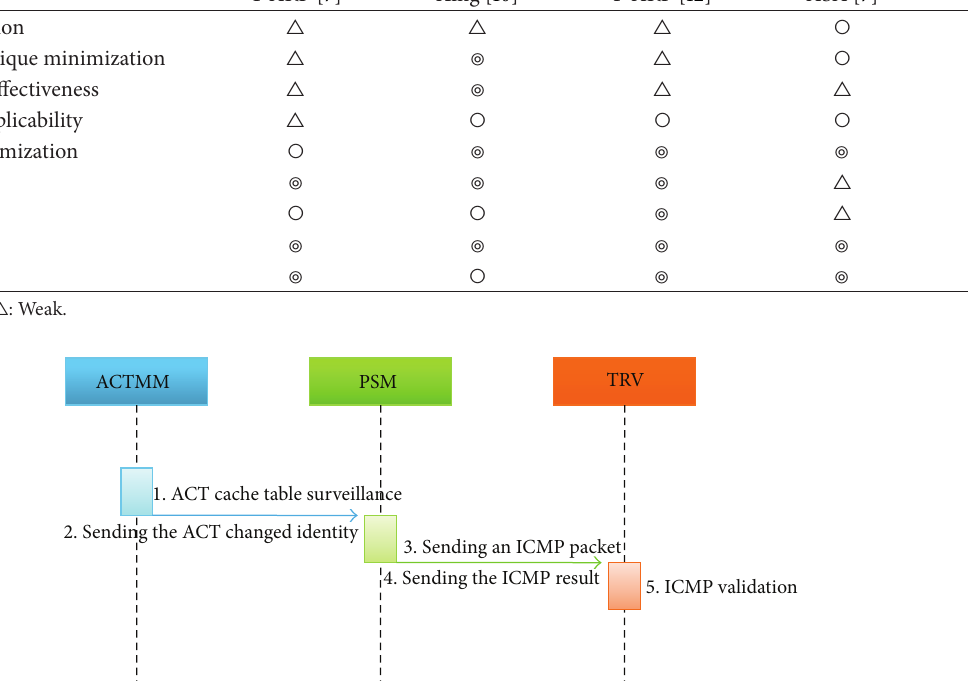
Figure 3: Protocol for the detection